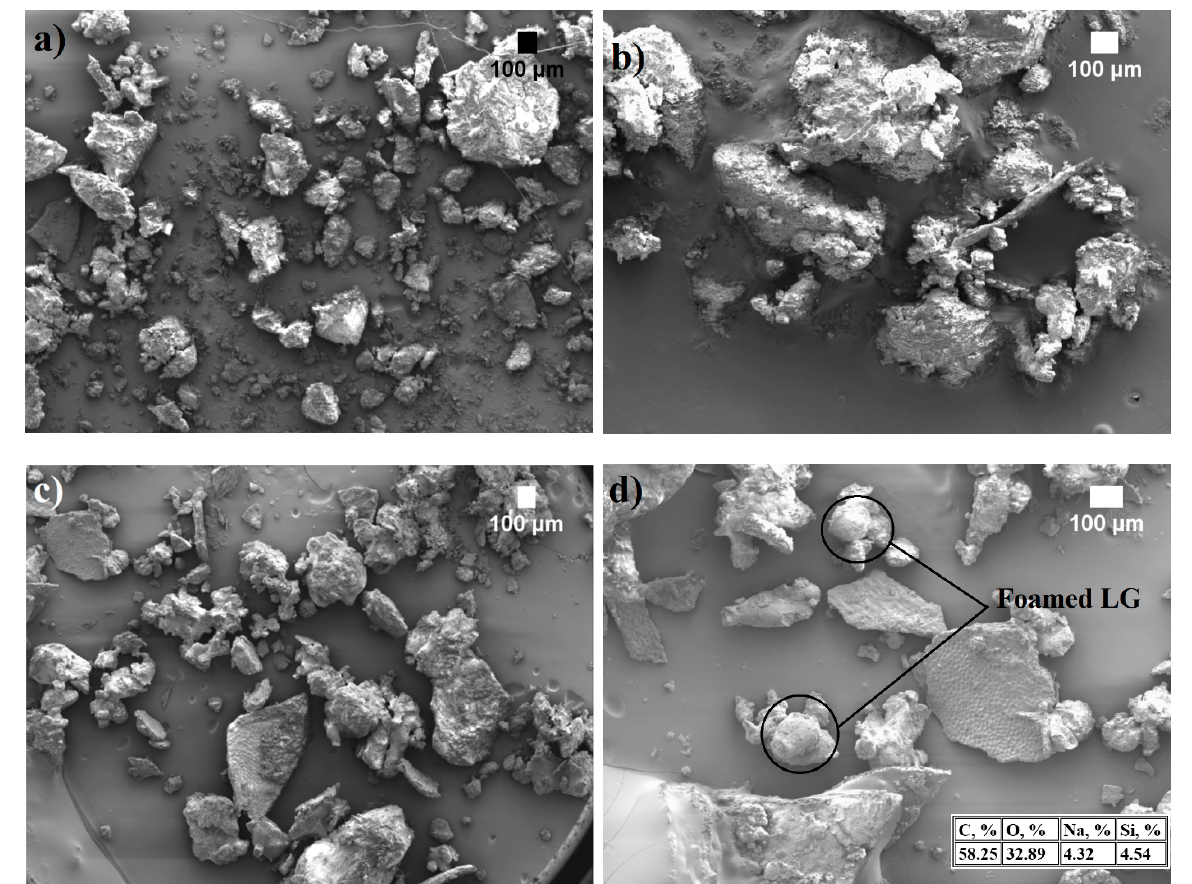
Figure 1. SEM images of particles’ microstructure: ( a ) SFP (x35 magnification); ( b ) SFP (× 60 magnification); ( c ) LG-SFP (× 35 magnification) and ( d ) LG-SFP (× 70 magnification).